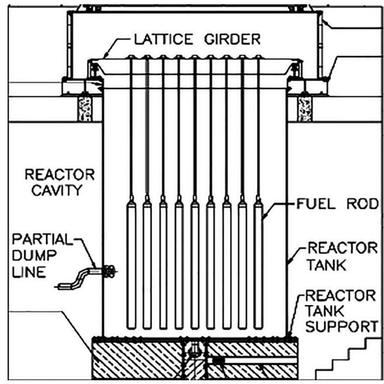
View of AHWR-CF nuclear reactor.